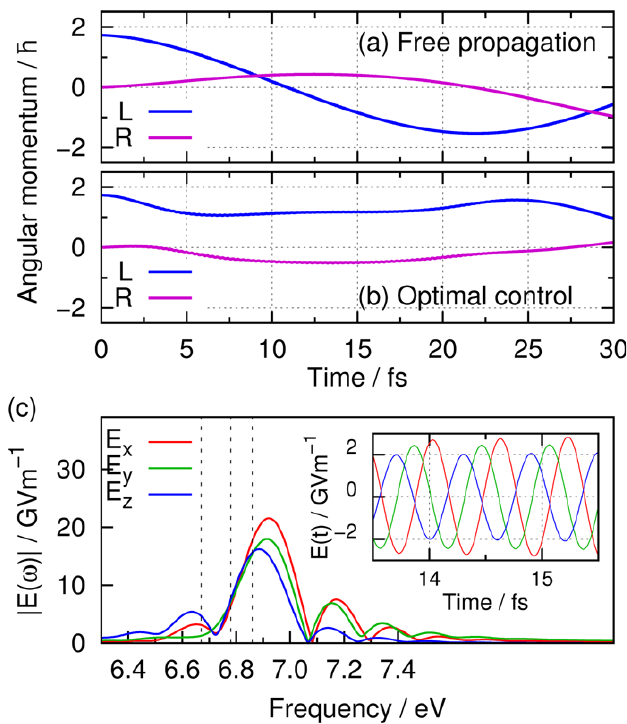
Figure 16. ( a ) Expectation values of π-electron angular momentum for the free rotations after the [AO] localization. ( b ) Results of the optimal control for maintaining the localization. The control time is t f = 30 fs. ( c ) Absolute values of the optimal electric field. The inset figure is the field in the restricted time domain. Reprinted from [91] with permission of the American Chemical Society.